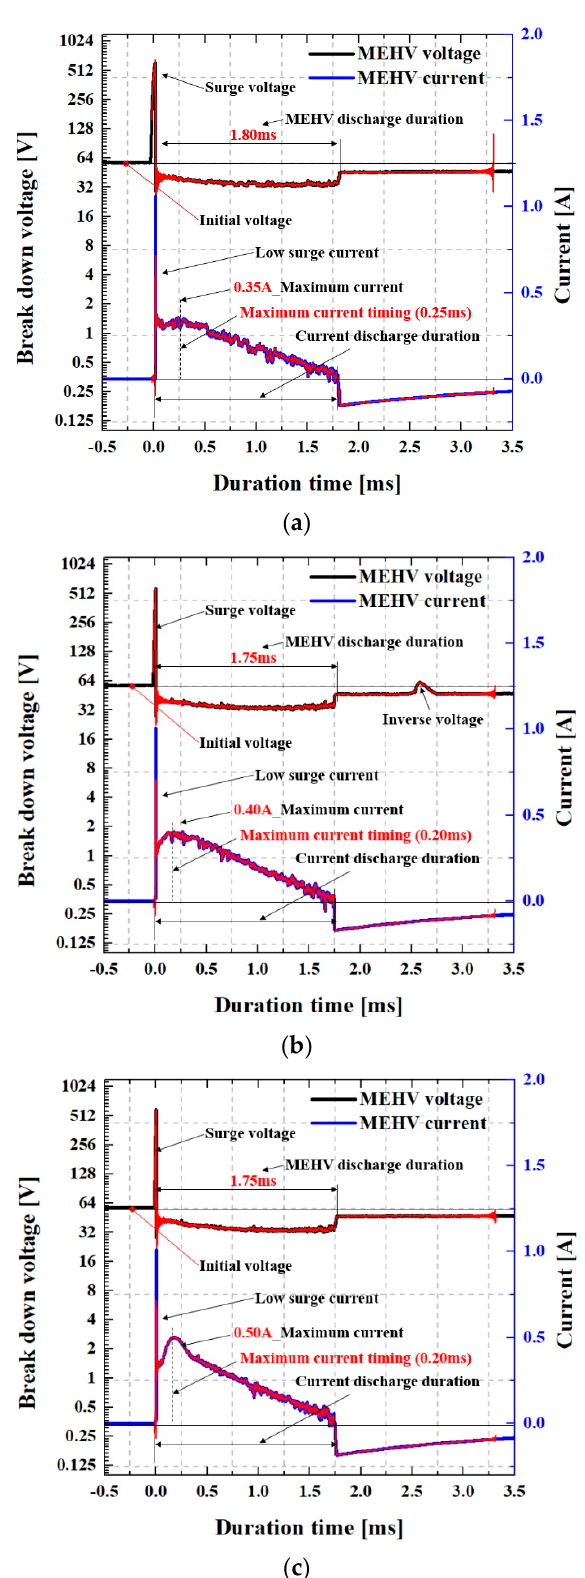
Figure 7. Voltage and current of MEHV based on capacitive discharge ignition (CDI): ( a ) 50 V + 400 V initial voltage of MEHV; ( b ) 100 V + 400 V initial voltage of MEHV; ( c ) 150 V + 400 V initial voltage of MEHV.